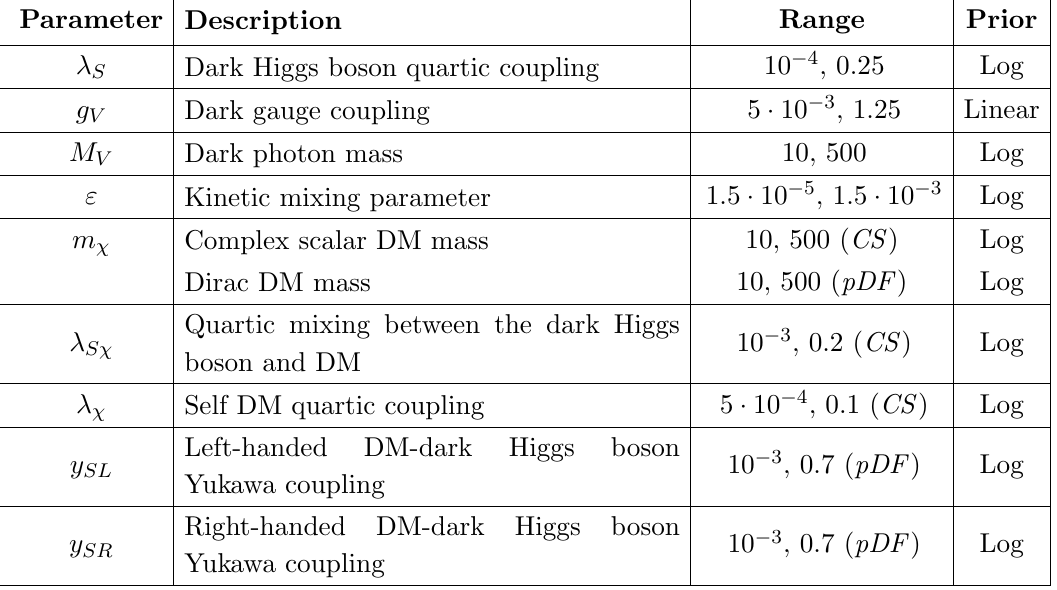
Table 1. Parameters of the models analyzed in this work. All parameters are initialized at the electroweak scale. Dimensionful quantities are given in MeV and MeV 2